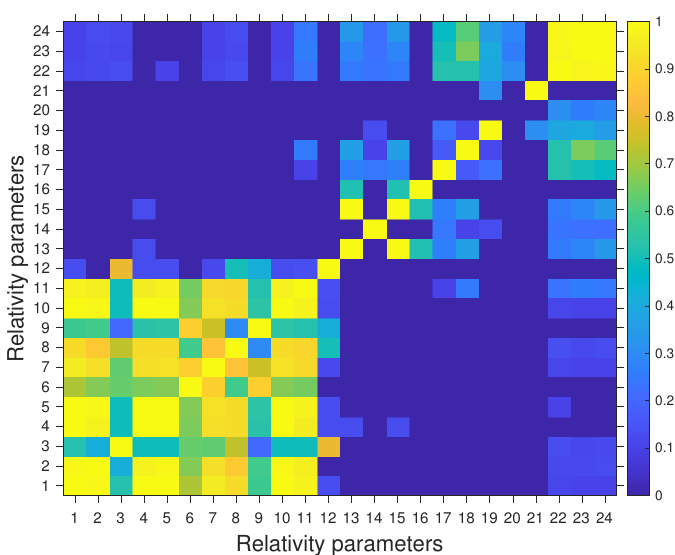
Figure 3. Absolute value of the correlations between the estimated parameters in the case of simulation (b). The parameters are labeled as in Tables 3 and